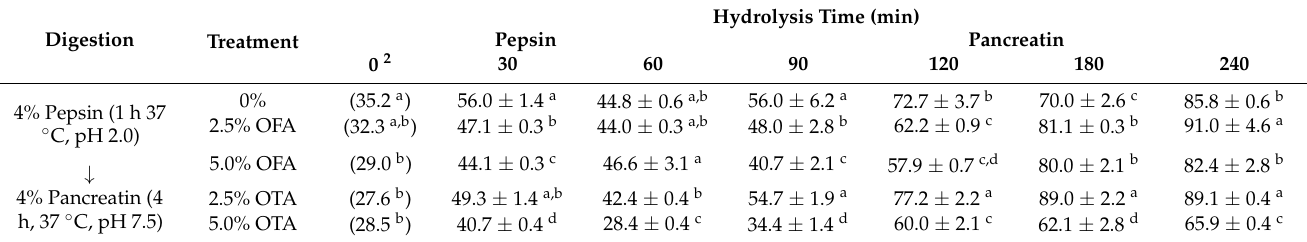
Table 4. In vitro sequential digestion rate of oxidized ferulic (OFA) and tannic (OTA) acid-treated WPI films 1 . Digestion